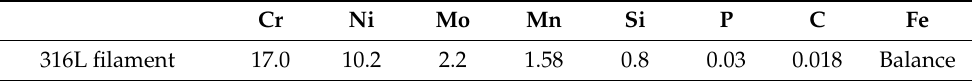
Table 1. Chemical composition of 316L stainless steel acquired from PT+A GmbH, wt. %.